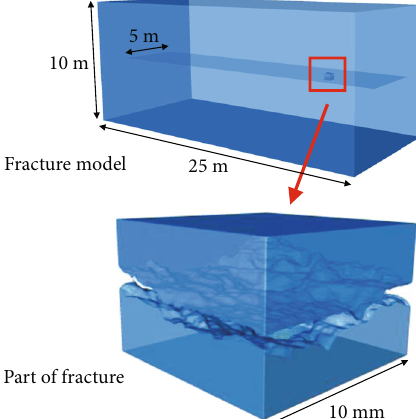
Figure 2: Sandstone model with a single fracture and the aperture distribution of the local